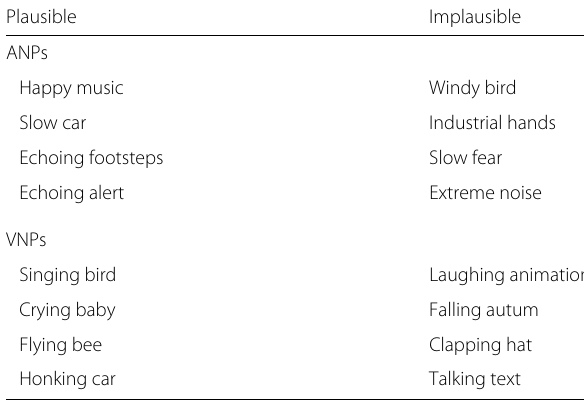
Table 1 Examples of plausible and implausible